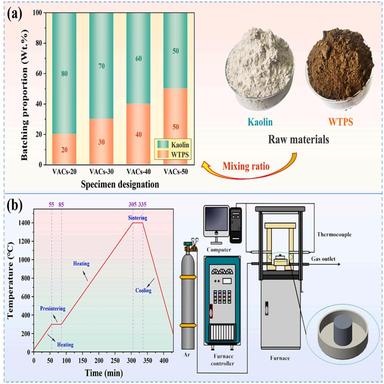
(a) Batch composition and specimen designation of VACs; (b) Program design of electric furnace temperature throughout sintering.